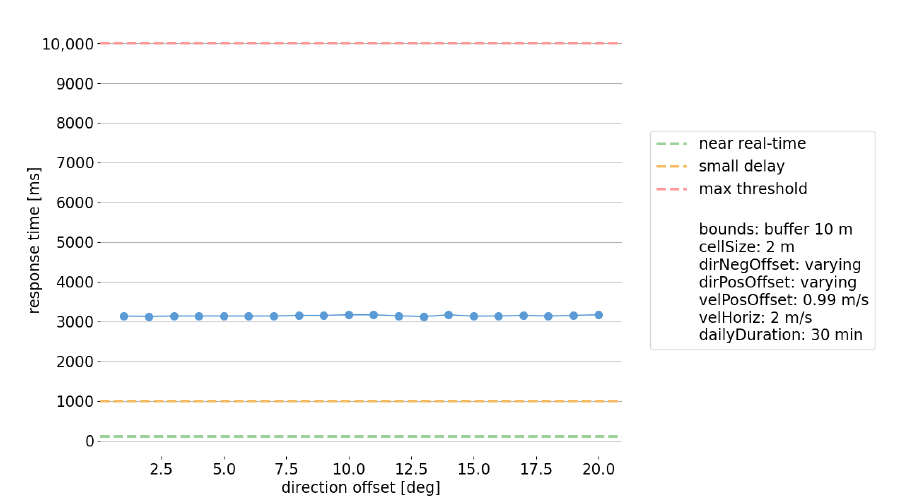
Figure 17. The response times when the wind direction offset varies. The velocity_plan showed an exponential decay in the response time, while the hori- zontal velocity high-pass filter increased. This is an expected behavior in a city environment since blocking and occlusions by above surface objects decrease the wind velocity resulting in many locations with lower wind speeds. Despite the fact that there were cases above the 10,000 milliseconds threshold, the wind velocity was in the range of 1–1.3 m/s, which, in fact, is not a realistic scenario for a promising wind power yield (Figure